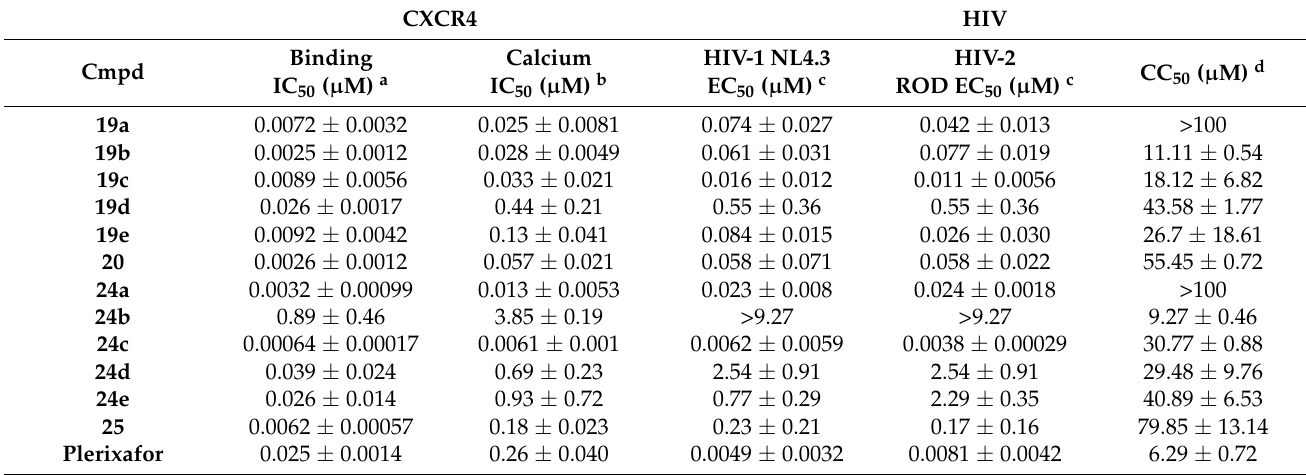
Table 1. CXCR4 and HIV data of final